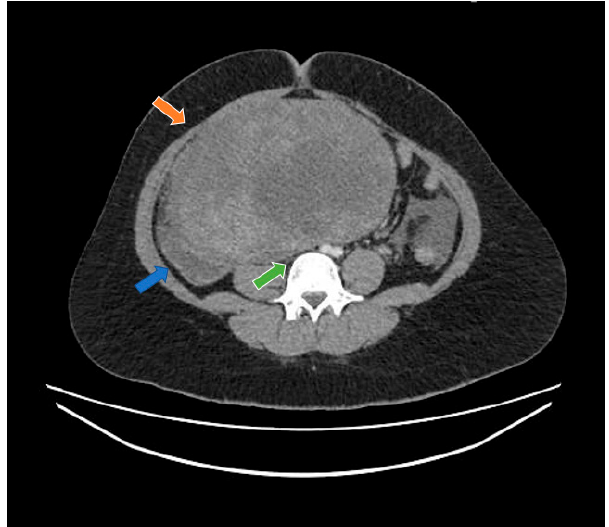
Figure 1. Computed tomography study in the portal phase showing a heterogeneous mass in the pelvic region (orange arrow), displacement of the intestinal loops to the right (blue arrow), and compression over the inferior vena cava (green arrow).